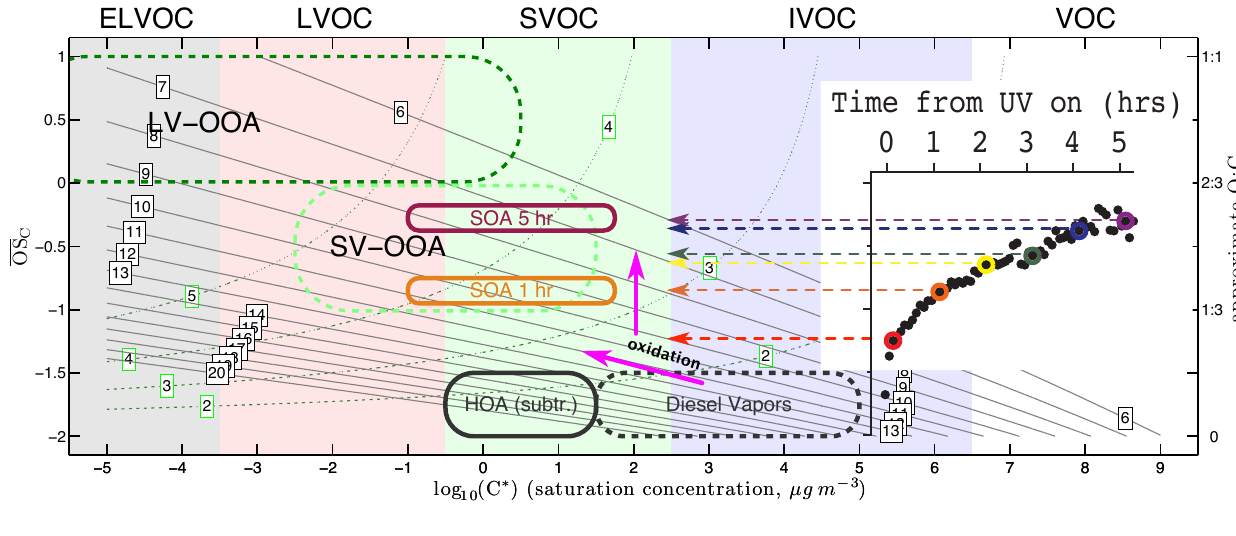
Fig. 6. Progressive oxidation of secondary organic aerosol produced by oxidation of diesel vapors. The inset shows the oxidation state of a residual mass spectrum (HOA removed). OS C rises steadily through the experiment; the value at each hour is indicated with a colored circle and colored lines mapping to the 2-D-VBS. Contours are carbon number (gray) and oxygen number (dashed green) as in Fig. 5.